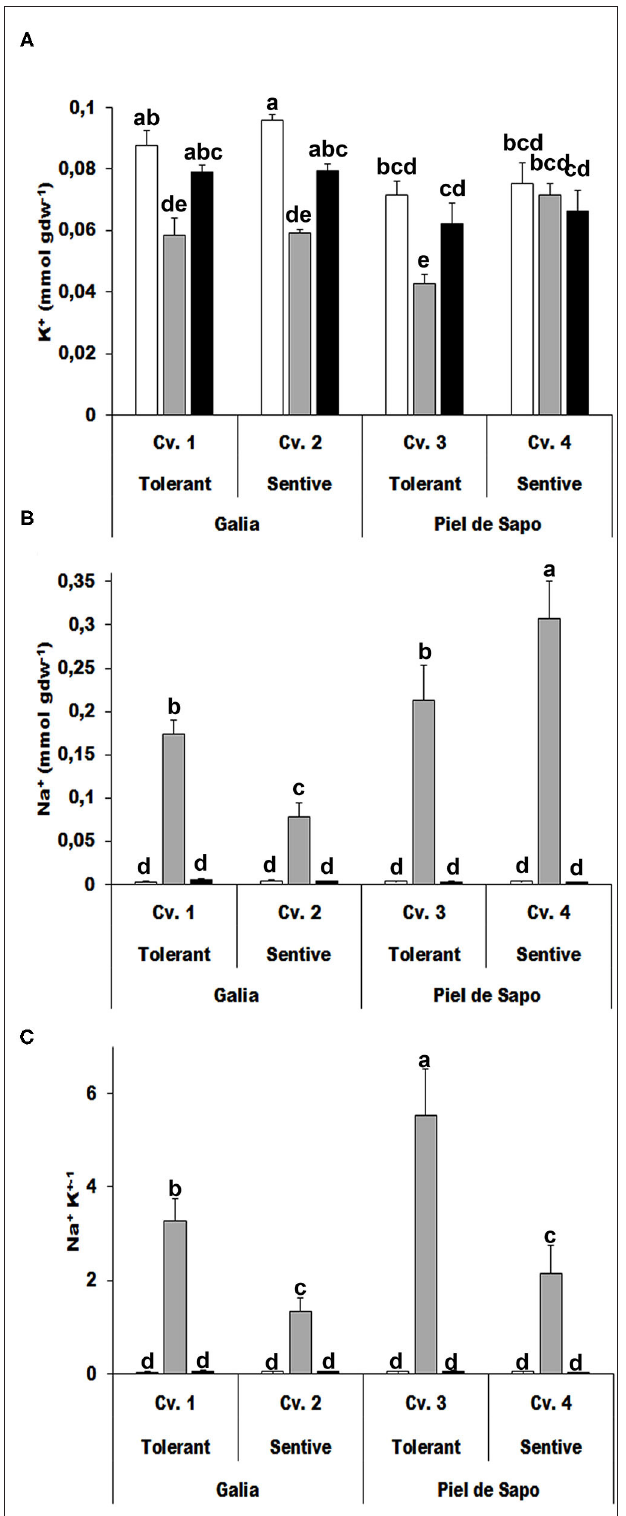
FIGURE 5 | Ion content determination. Potassium content (K + ) (A) , sodium content (Na + ) (B) , and the Na + /K + ratio (C) of the tolerant Galia genotype (Cv. 1), sensitive Galia genotype (Cv. 2), tolerant Piel de Sapo genotype (Cv. 3), or